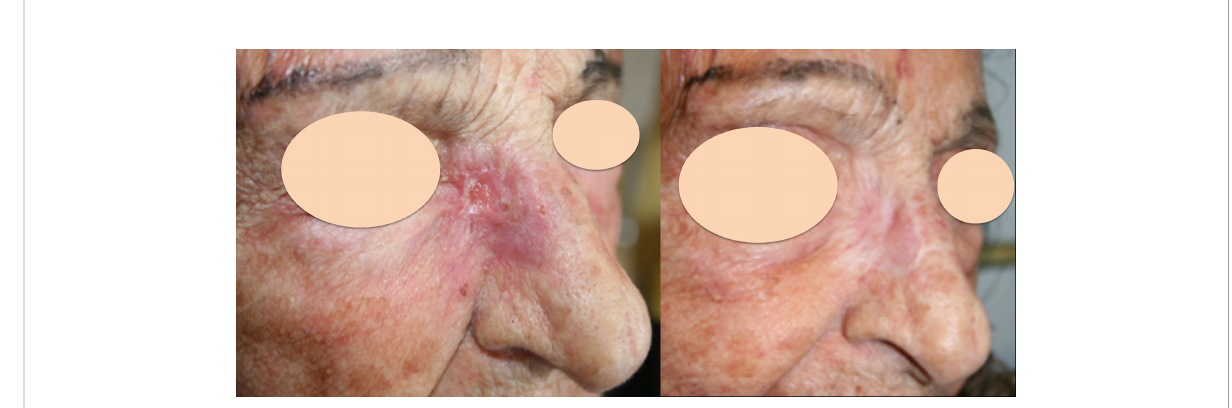
FIGURE 1 Recurrent cutaneous SCC of the inner cantus after previous surgery. Left: before ECT; Right: complete response 5 months after